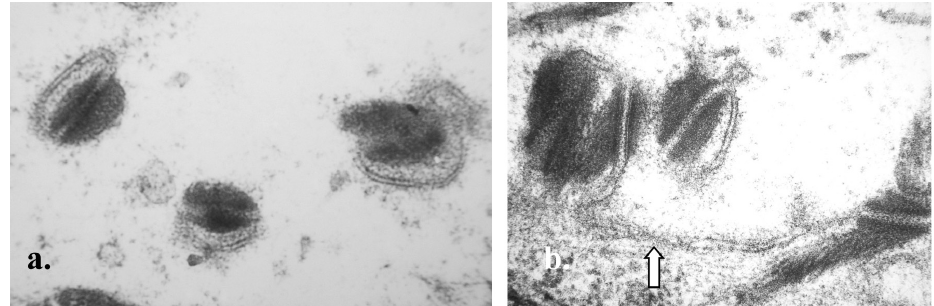
Figure 4 – One hour after induction a. Free desmosomes with curved cell membranes, which are not linking one desmosome to each other (x 120.000). b. Free desmosomes and membrane degeneration (arrow) (x